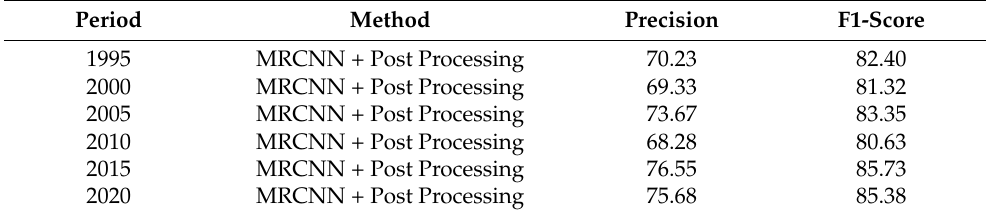
Table 5. Classification precision (%) after post-processing. Period Method